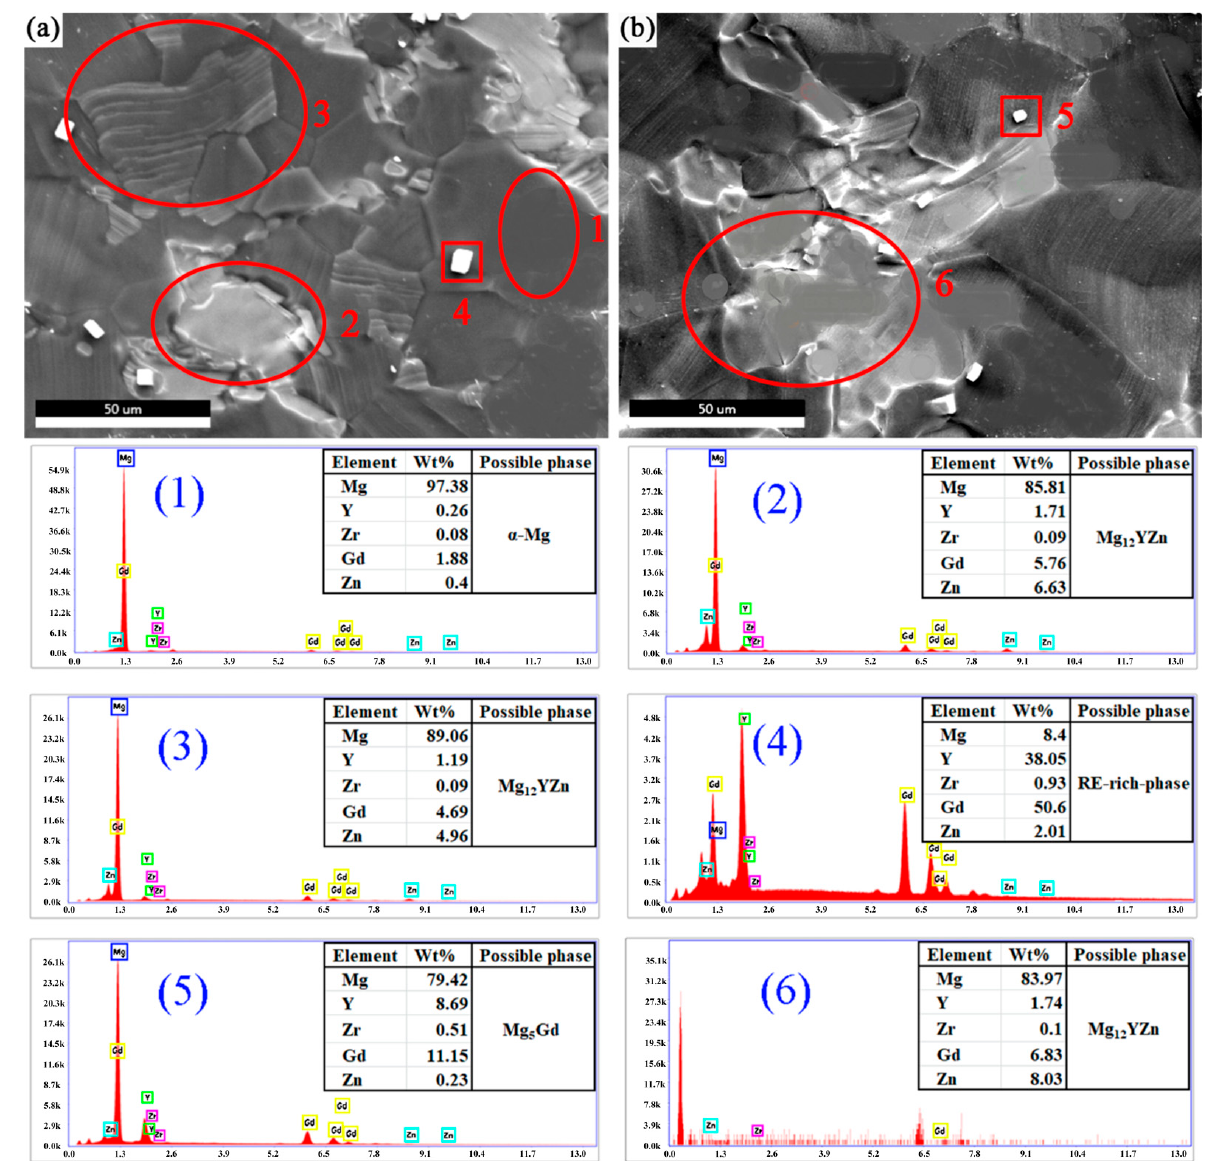
Figure 4. EDS analysis selection map of 510 °C × 13 h solid solution alloy. ( a , b ) correspond to different positions on the same sample .